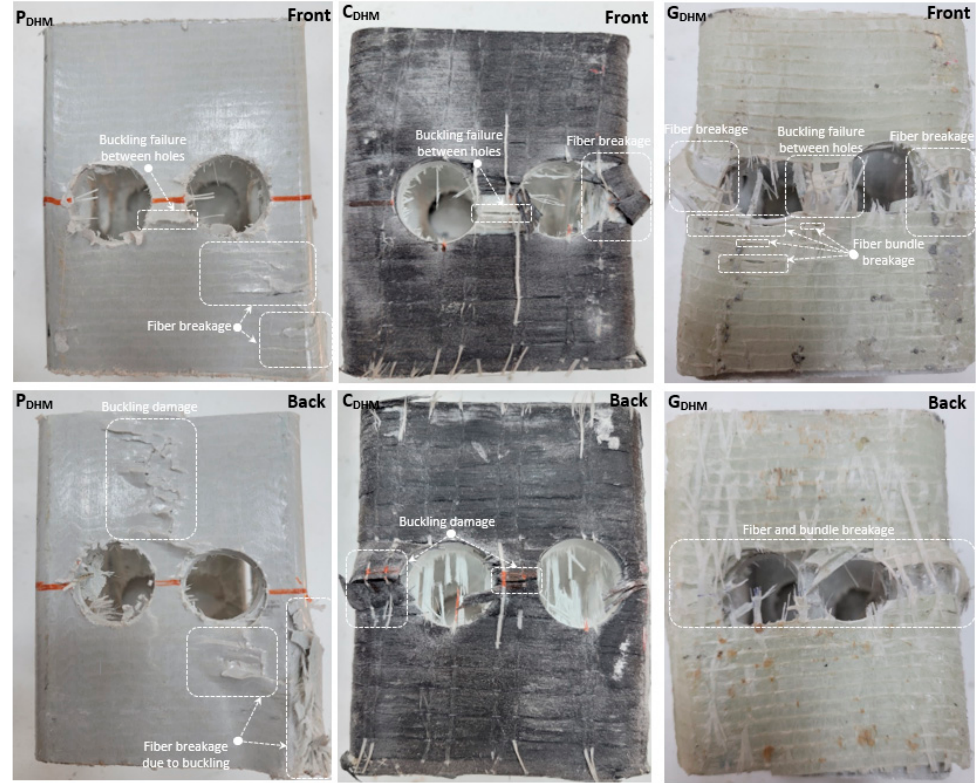
Figure 8. Damage analyses of P DHM , C DHM , and G DHM .